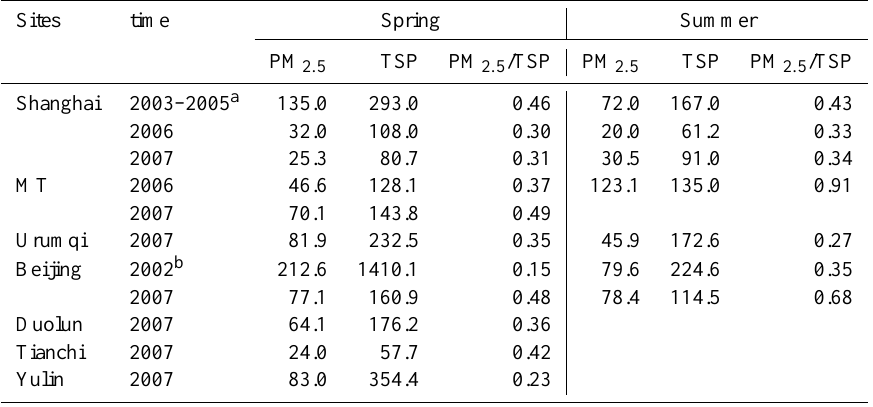
Table 2. Mass concentrations (µgm − 3 ) and size distributions of aerosols at the summit of MT and other sampling sites. Sites time Spring